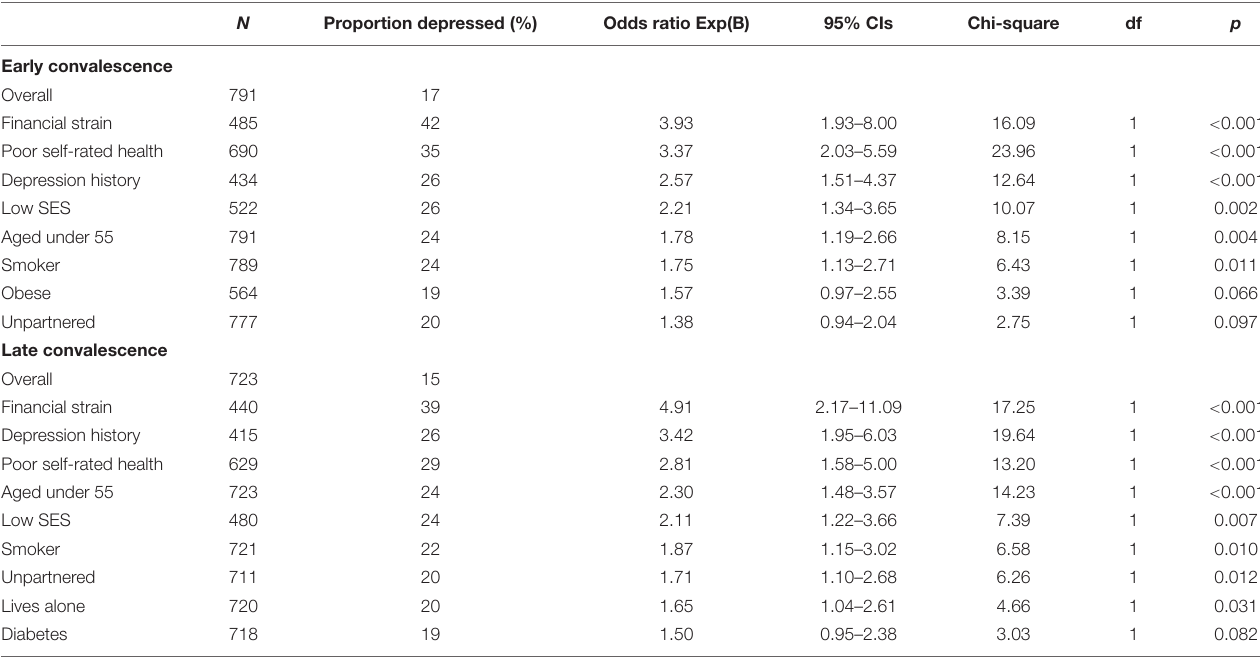
TABLE 3 | Factors associated with depression in early and late